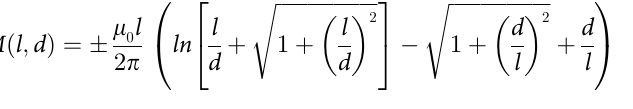
ffiffiffiffiffiffiffiffiffiffiffiffiffiffiffiffiffiffiffiffi